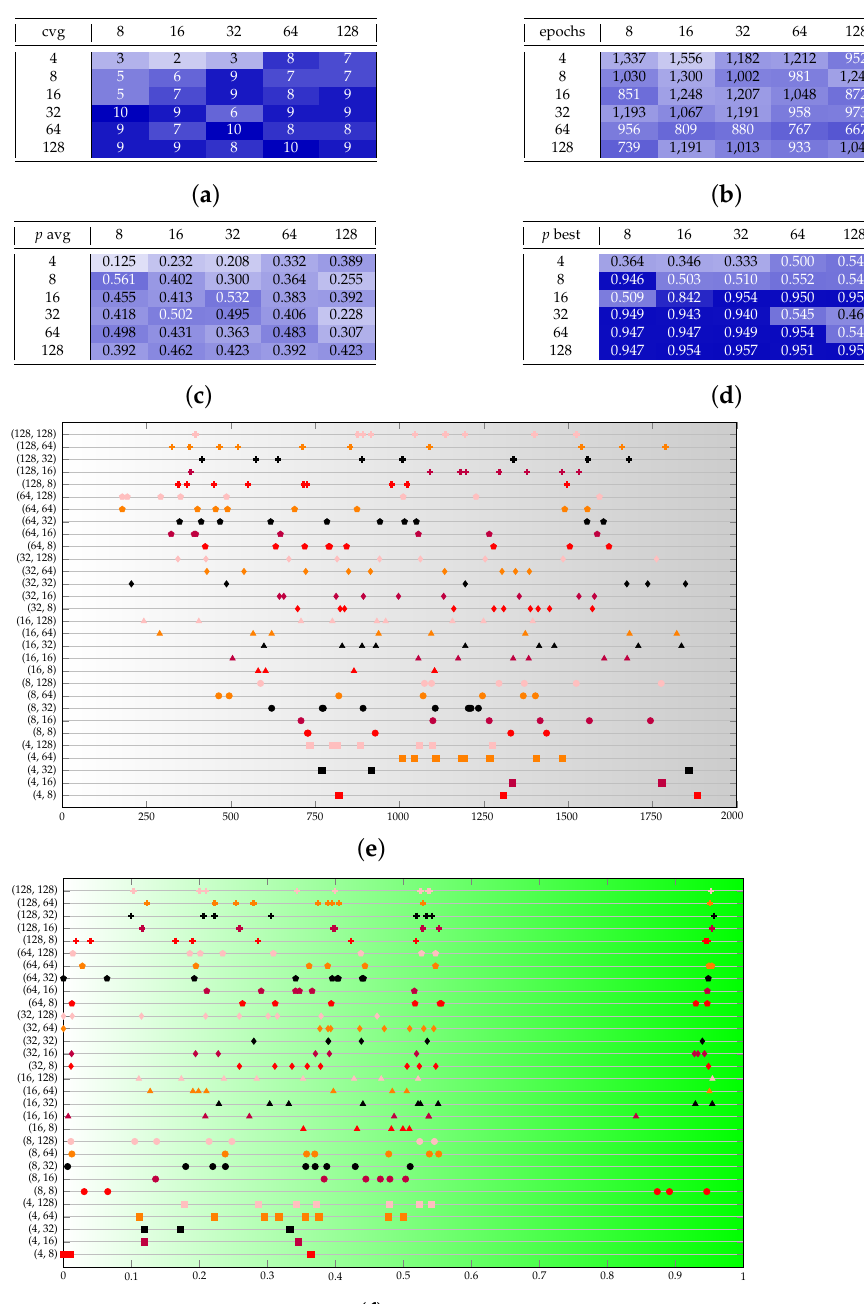
(f) Visualrepresentationofthe p -value. FigureA5. ThetestsetDprovidesasensitivityanalysisonthediscriminatorsize. InSubfiguresA5a-A5dtherowsrepresent H 1 and Figure A5. Test set D provides a sensitivity analysis on the discriminator size. ( a – d ) The rows thecolumns H 2 . InSubfiguresA5e-A5f,thecouplesontheverticalaxisare ( H 1 , H 2 ) ,markershapesrepresent H 1 andmarkercolors represent H 2 . represent H 1 and the columns H 2 . ( e , f ) The couples on the vertical axis are ( H 1 , H 2 ) . The marker shapes represent H 1 and marker colors represent H 2 . ( a ) Converging runs, out of 10. ( b ) Number of epochs before convergence, on average. ( c ) p -value for the χ 2 test once convergence is reached (average over converging runs). ( d ) p -value for the χ 2 test once convergence is reached (best run). ( e ) Visual representation of the epochs before convergence. ( f ) Visual representation of the p (a) Convergingruns,outof10. (b) Numberofepochsbeforeconvergence,onaverage.